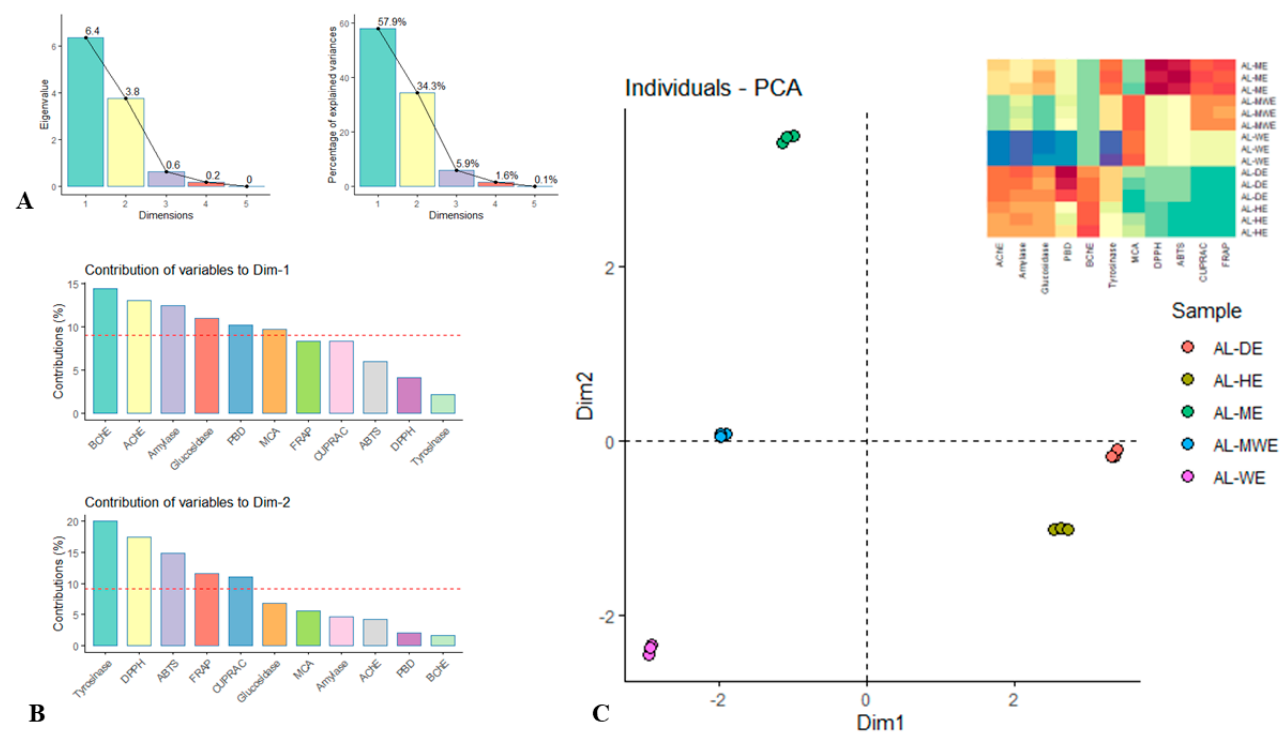
Figure 6. Principal component analysis on the biological activities of the A. campestris subsp. lednicensis aerial part extracts. ( A ) Eigenvalue and percentages of the explained variances of each dimension. ( B ) Contribution of variables on the dimensions of PCA. ( C ) Scatter plot showing the distribution of the samples in the two retained dimensions.